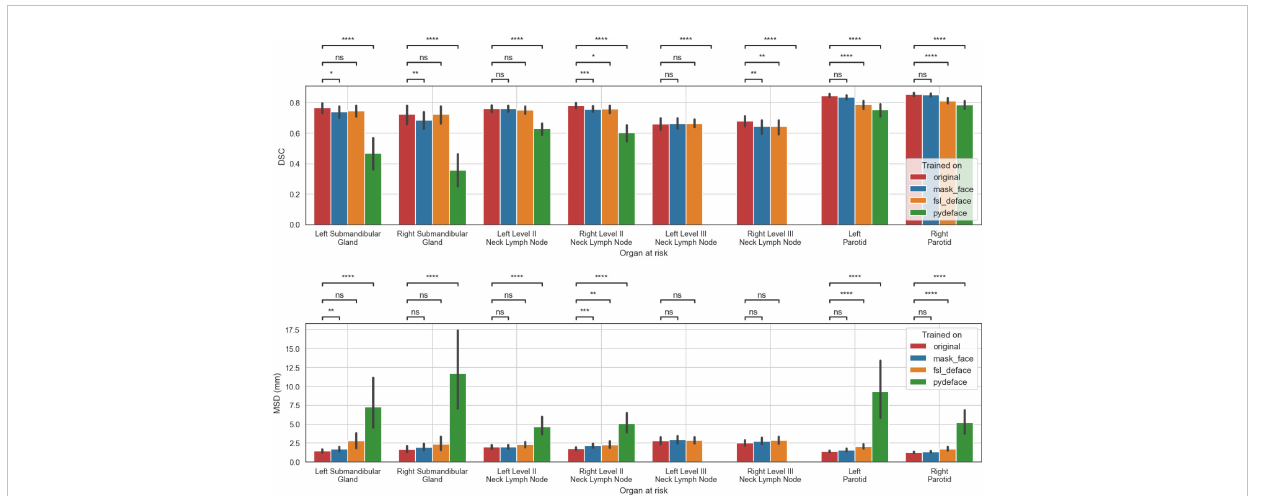
FIGURE 3 Performance of the models trained on original or defaced data and evaluated on the original data. The mean and standard deviation for each metric are represented as the center and extremes of the error bars, respectively. Statistical signi fi cance was determined using Wilcoxon signed-rank tests corrected with Benjamini-Hochberg procedure for all OARs and models. Comparison symbols: ns (p > 0.05), * (p ≤ 0.05), ** (p ≤ 0.01), *** (p ≤ 1e- 4), **** (p ≤